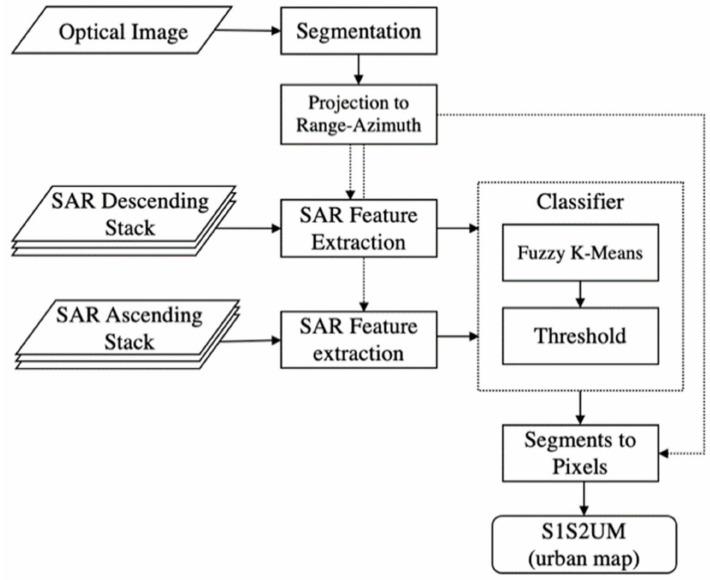
Figure 5. Flow chart of the proposed algorithm for urban